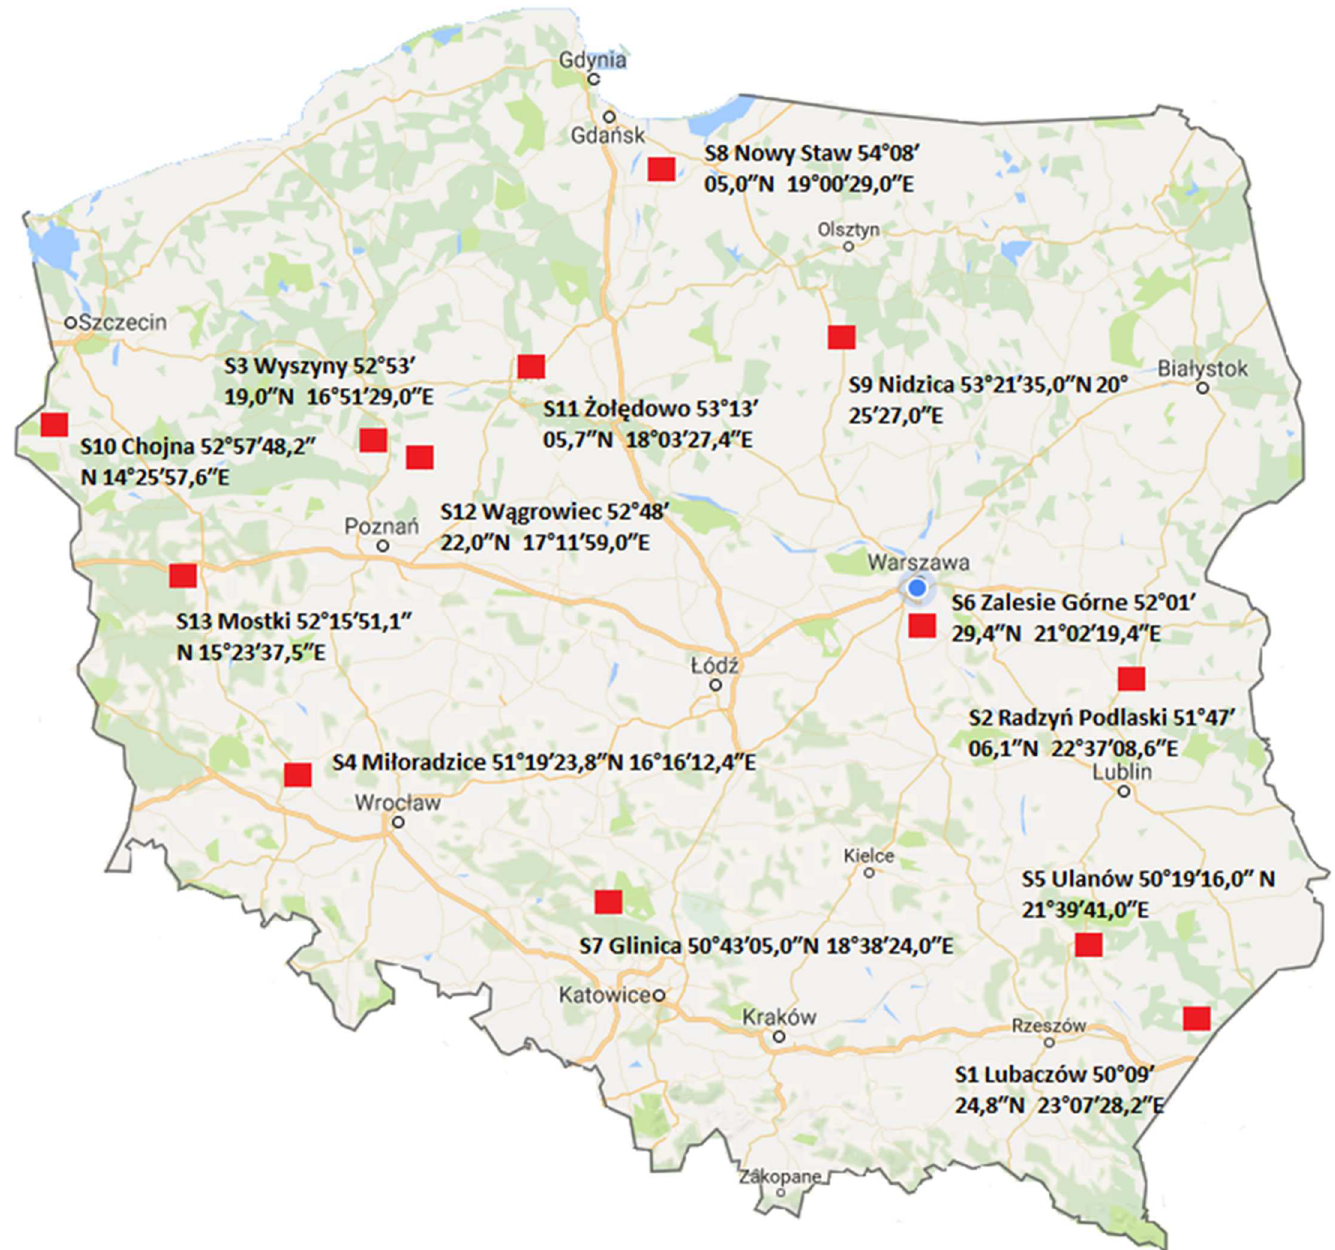
Fig 1. Bee pollen sampling